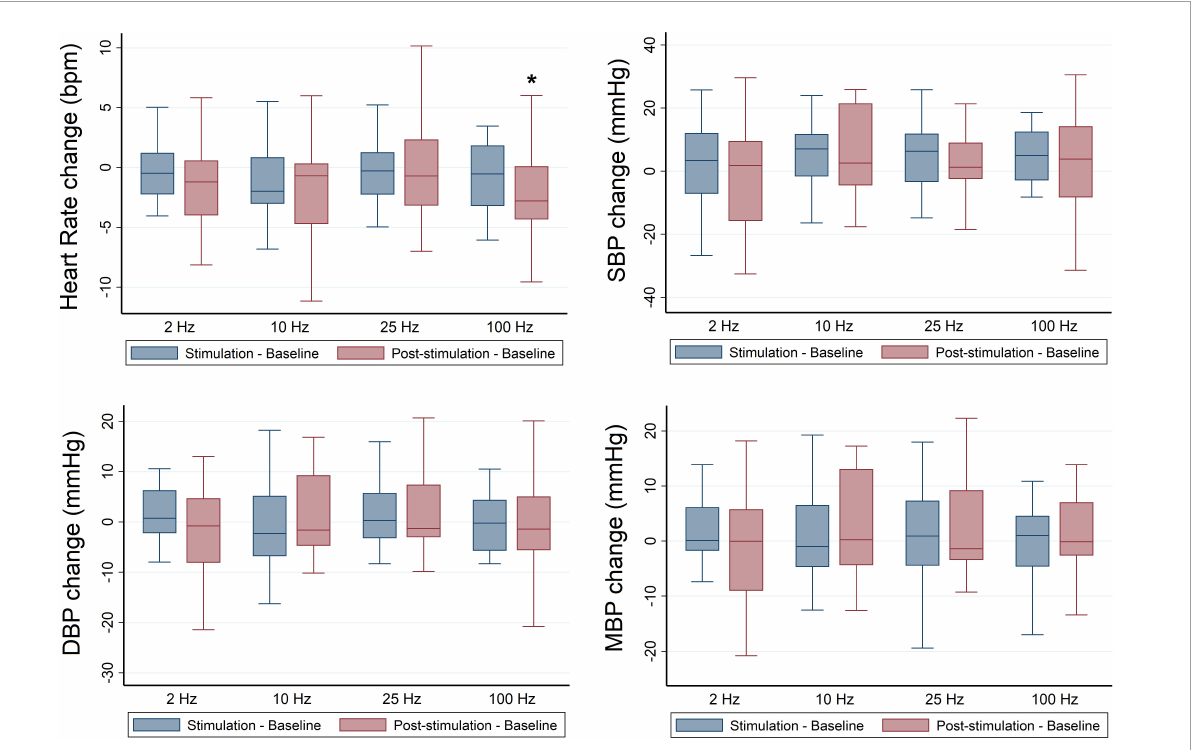
FIGURE2 Frequency-dependent effects of RAVANS on the regulation of heart rate, systolic blood pressure (SBP), diastolic blood pressure (DBP), and mean blood pressure (MBP) in participants included in the study. Changes in variables estimated as absolute difference from baseline in comparison with sham stimulation. * p <